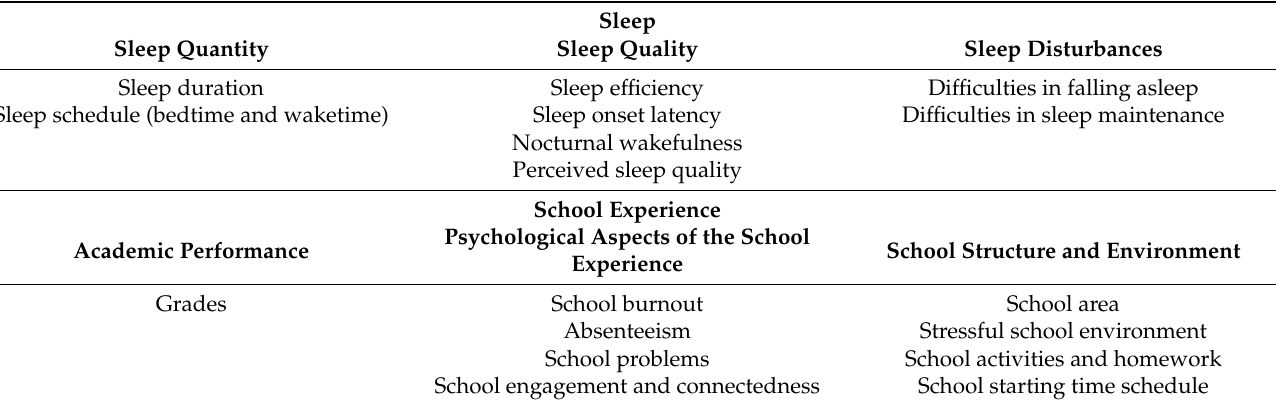
Table 1. Main categories of sleep and school experience